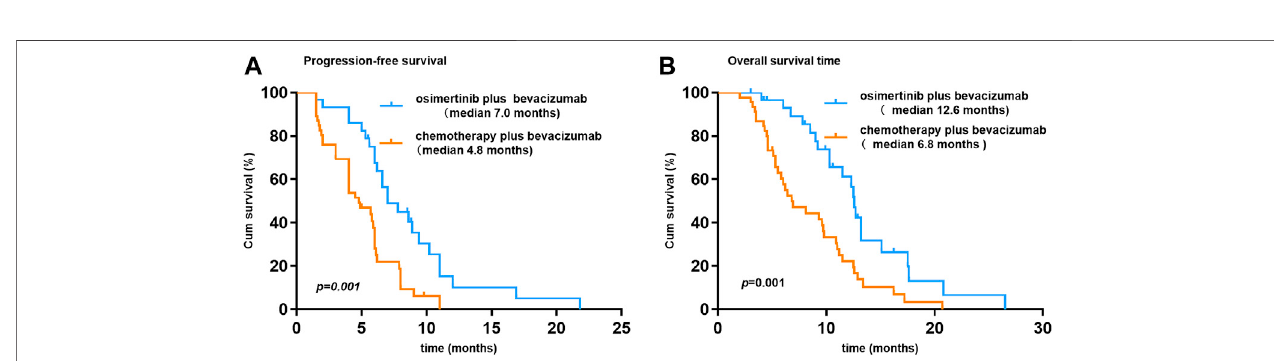
FIGURE 4 | Kaplan – Meier curves of progression-free survival and overall survival for patients who received bevacizumab at 7.5 mg/kg.